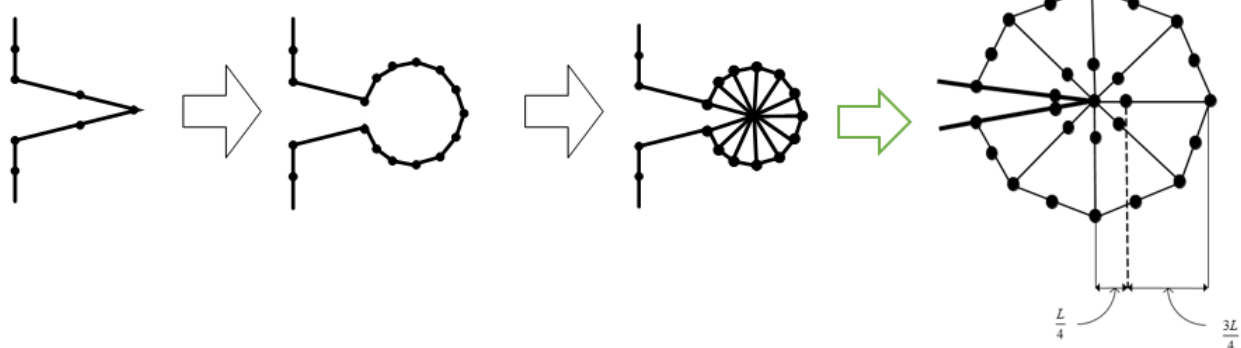
Figure 3. Steps of generating quarter-point elements around a crack tip.